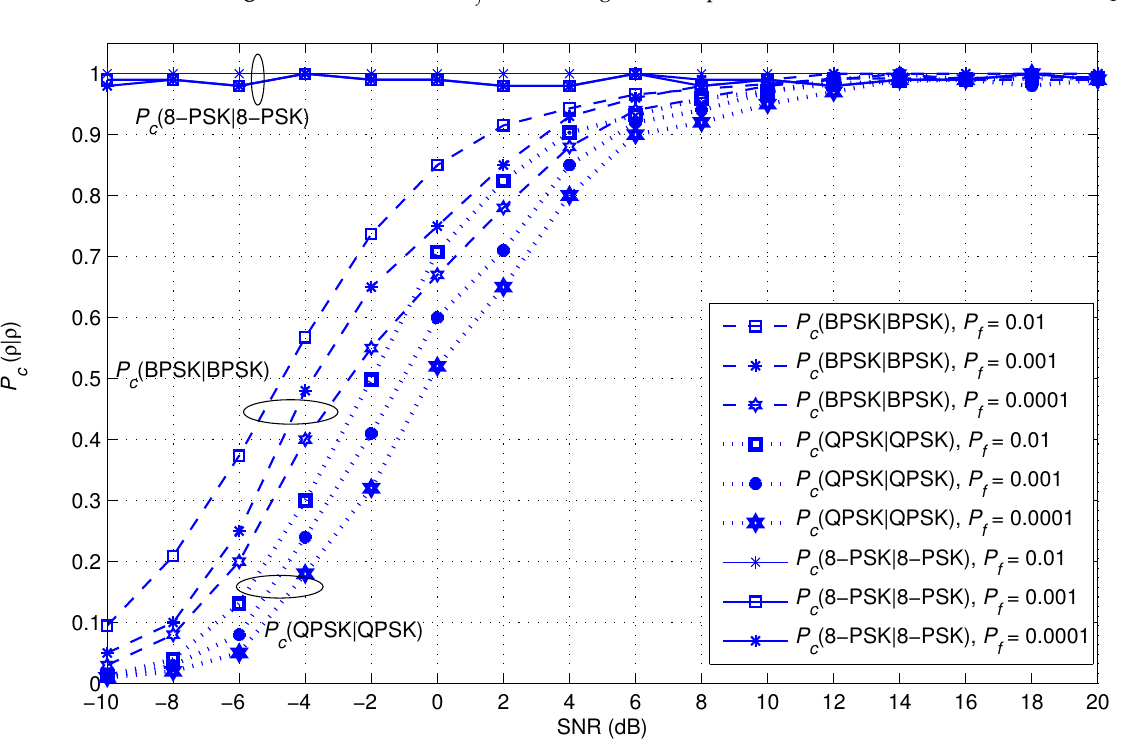
Figure 12. The effect of P f on the categorization performance for the modulation set of Ω 1 .